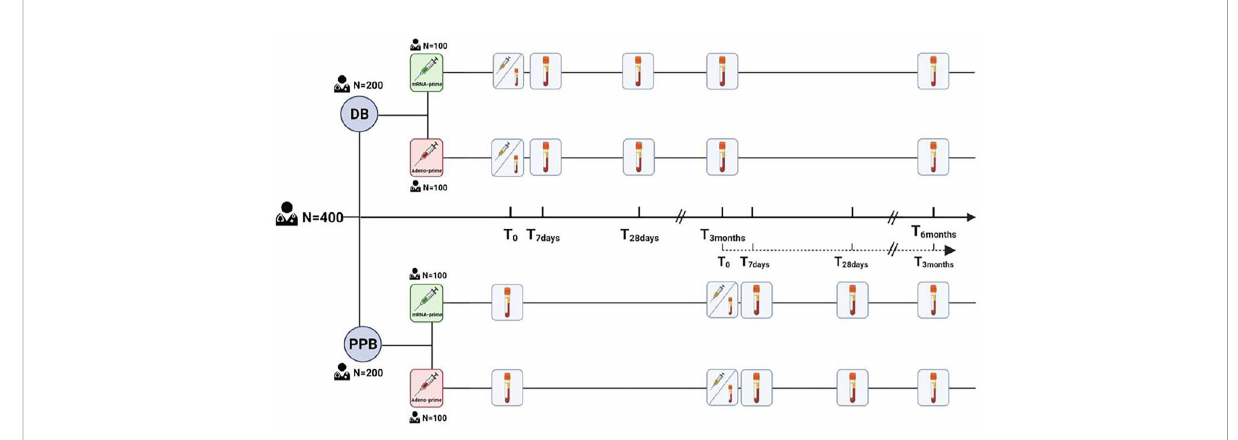
FIGURE 1 The 400 participants will be split into two groups, each consisting of 100 participants primed with Ad26.COV2.S (red) and 100 participants primed with an mRNA-based vaccine (green). The immunological response will be measured on day 0, 7, 28, and at 3 and 6 months after